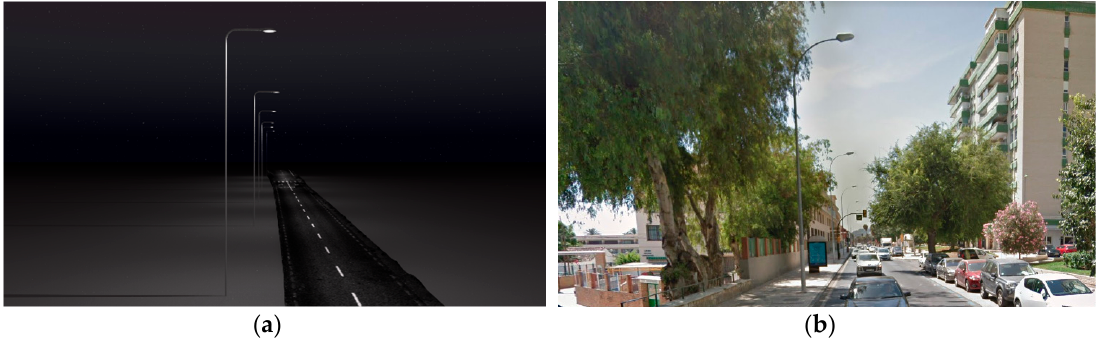
Figure 5. Lighting scene used on the simulation and the calibration process: ( a ) 3D rendering and; ( b ) real scene.